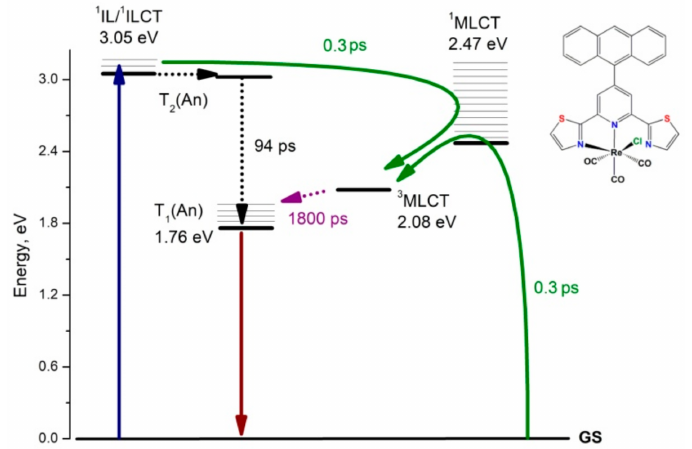
Scheme 2. Qualitative energy level diagrams of the photophysical processes occurring in 3 in CHCl 3